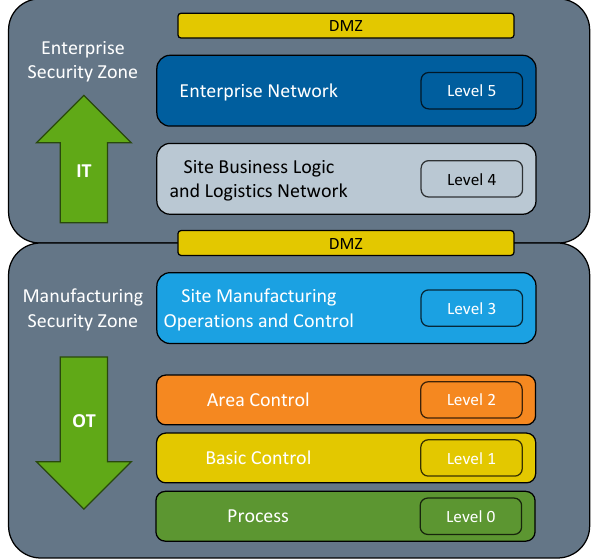
Figure 1. Common Architectural